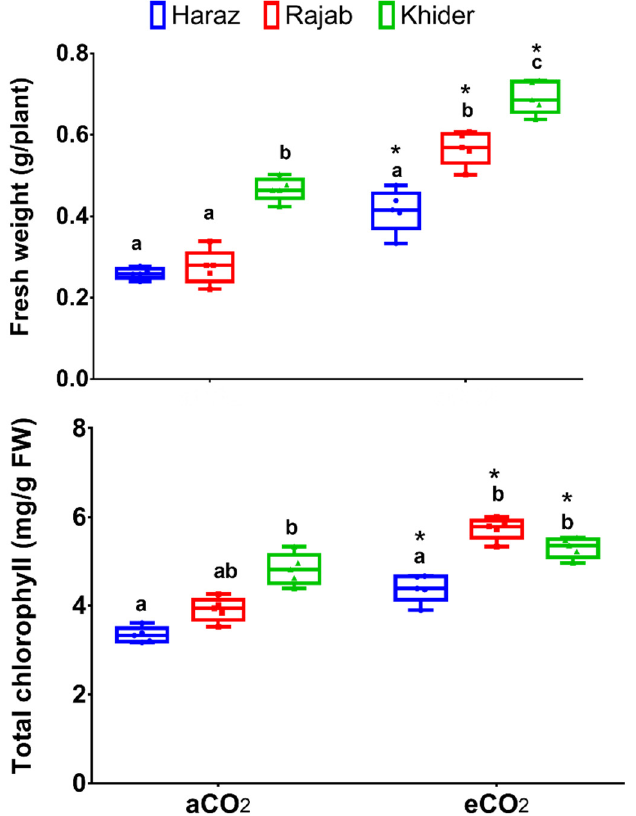
Figure 1. Fresh biomass and total chlorophyll content in sprouts of three Lepidium sativum cultivars grown under either aCO 2 (410 µ mol CO 2 mol − 1 air; control) or eCO 2 (620 µ mol CO 2 mol − 1 air). Values are presented as means ± standard error of 5 independent replicates. Different letters above the boxes at the same CO 2 level indicate significant differences at the 0.05 probability level as revealed by Tukey’s test. * Indicates significant changes ( p < 0.05) compared to the corresponding control, as revealed by Student’s t -test.